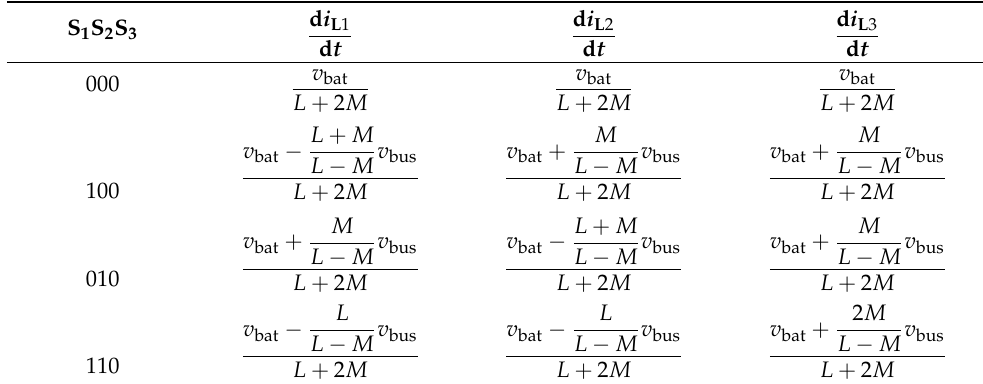
Table 1. Phase current changing